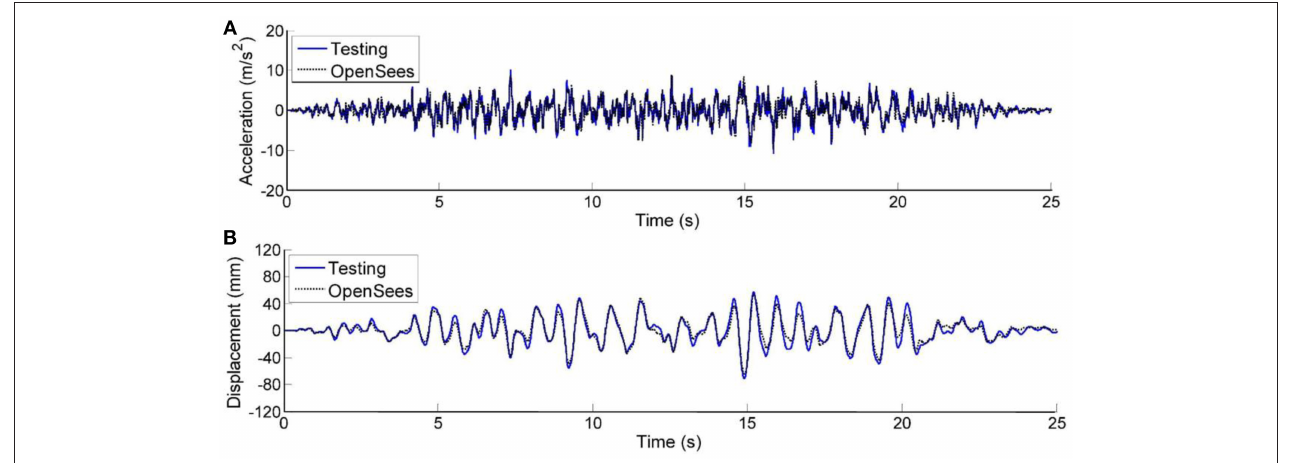
FIGURE 11 | Comparison between OpenSees and test result under AW-0.6g wave of (A) acceleration time history, and (B) displacement time history.